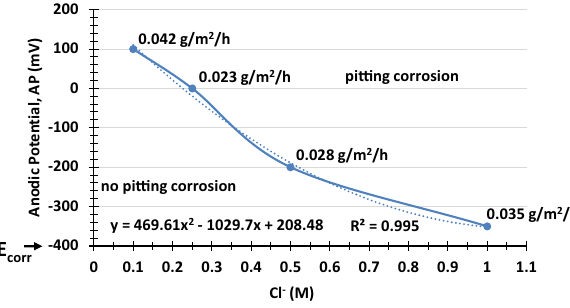
Figure 7: Relationship between AP inducing pitting corrosion on HSHCsw within 48 h time frame and Cl − concentration in deaerated electrolyte at pH 13.4 with the interpolation equation being applied only to the range of Cl − concentration from 0.1 to 1 M, with − 400 mV marked as E corr as in Figure 3. The rate of corrosion corresponding to each point on the curve is calculated based on equation ( 3 ) in this article.